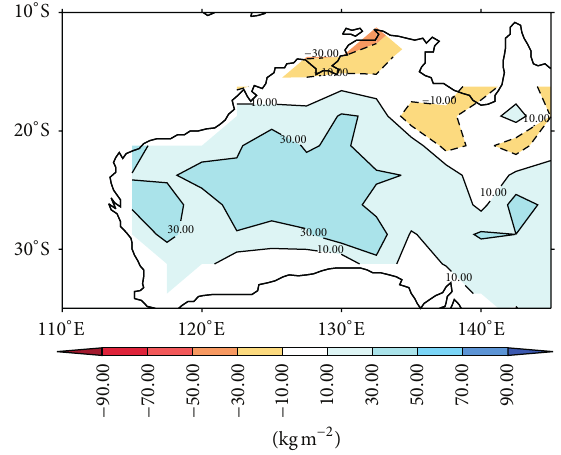
Figure 10: The difference in the total soil moisture content (kg m −2 ) between A1.1 and A1.0 averaged over all DJFs from 1979 to